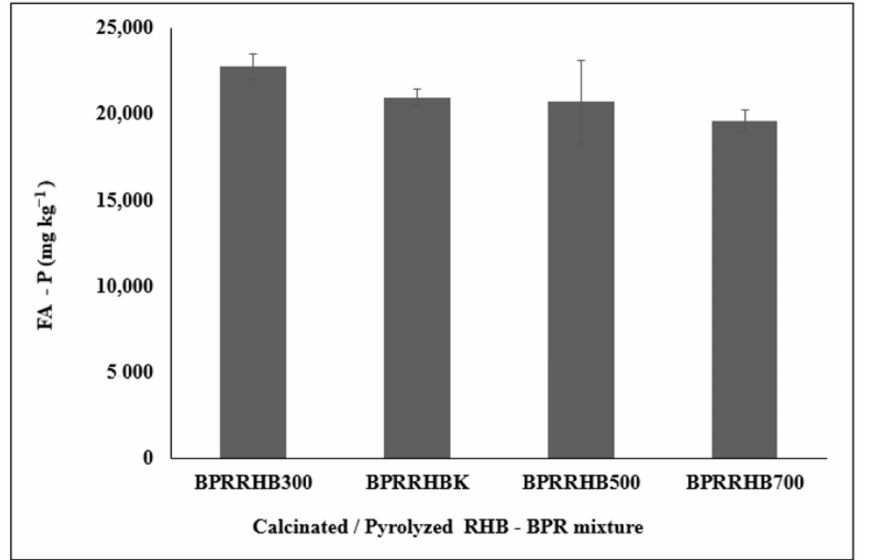
Figure 6. “Available” (i.e., formic acid-extractable) P content of RHB-BPR mixture at different pyrolysis/calcination temperatures showing no significant difference at p ≤ 0.05. Error bars are standard